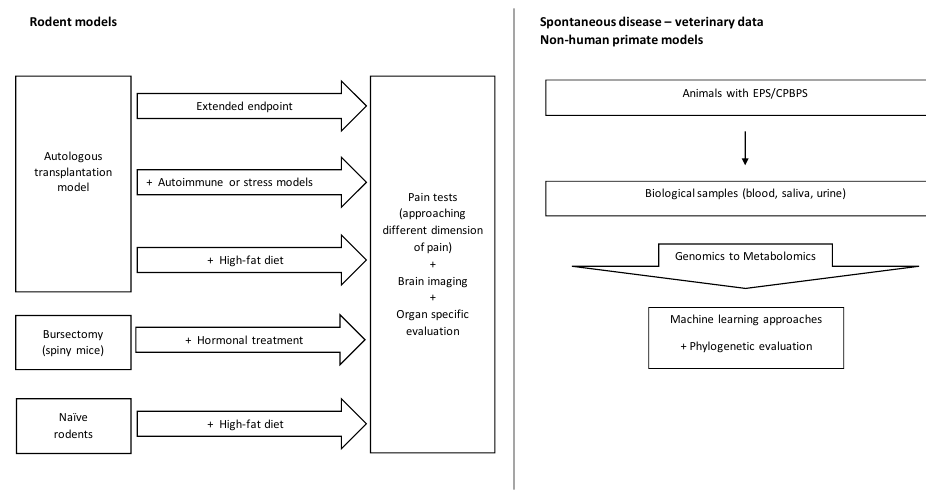
Figure 2. Possible refinement strategies to improve the study of chronic pelvic/visceral pain using animal models or animals that naturally develop EPS or CPBPS.